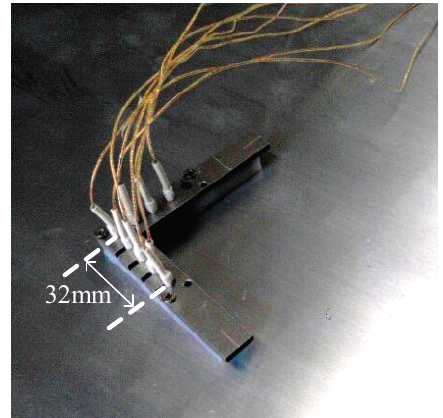
Figure 9. The 8-sensor